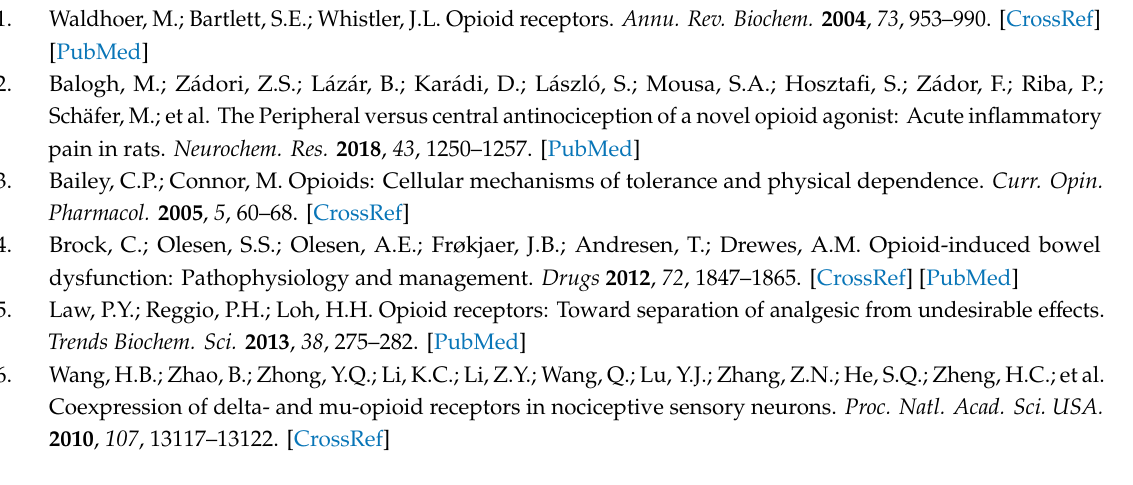
Supplementary Materials: The following are available online, Figures S1–S6: Analytical HPLC chromatograms of analogs 1 – 6 , Figures S7–S12: High resolution MS spectra of analogs 1 – 6 , Table S1: Physicochemical data of analogs 1 – 6